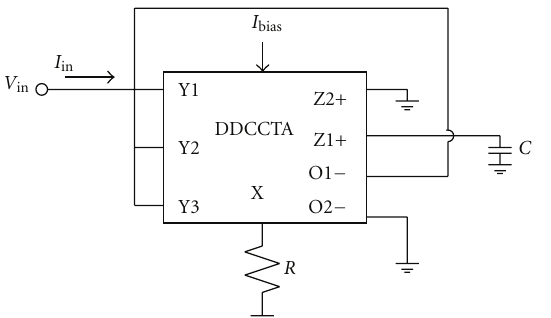
Figure 14: Grounded inductor simulator.